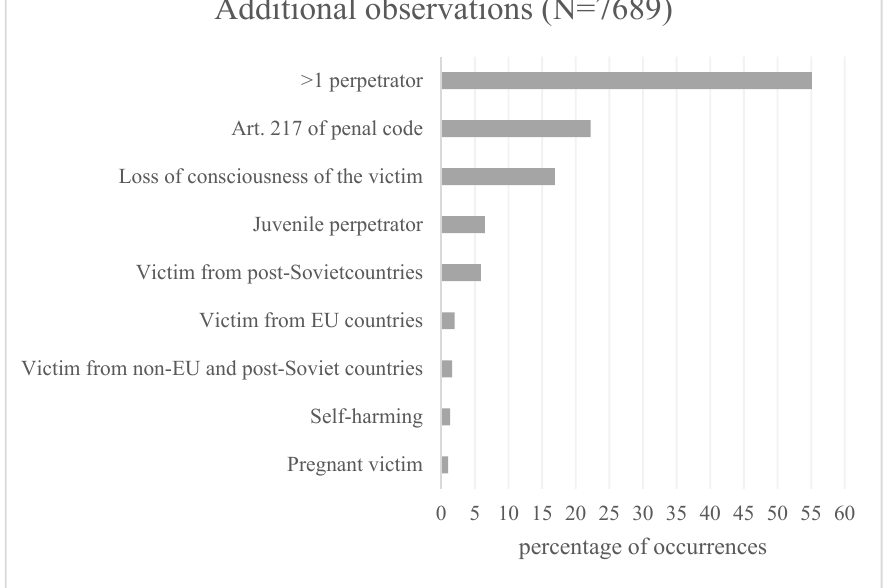
Figure 3. Additional observations.